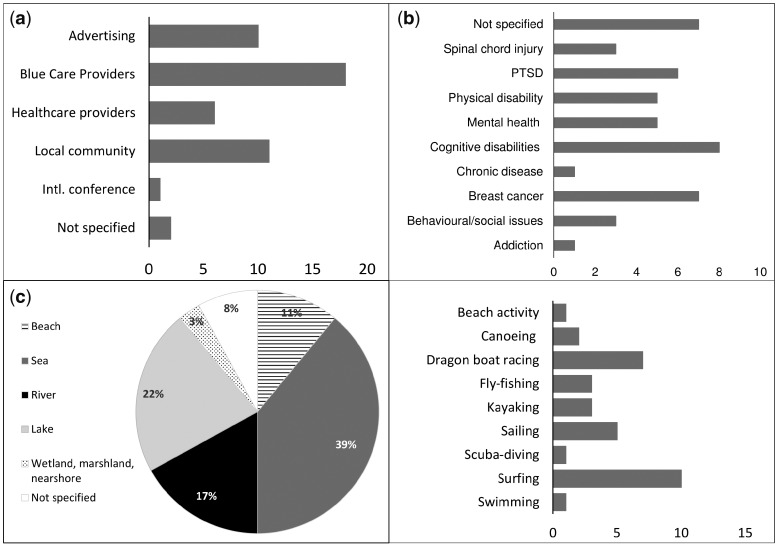
Results (numbers of studies) from analysis showing the recruitment procedures used in the studies (a), health characteristics of study population (b), type of blue space setting where interventions took place (c) and physical activities in blue care (d).